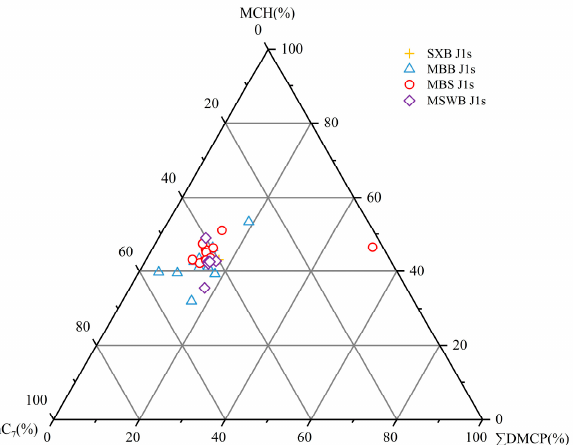
Figure 5. Characteristics of C 7 light hydrocarbons from natural gases in the eastern belt around the Penyijingxi sag, Junggar Basin.